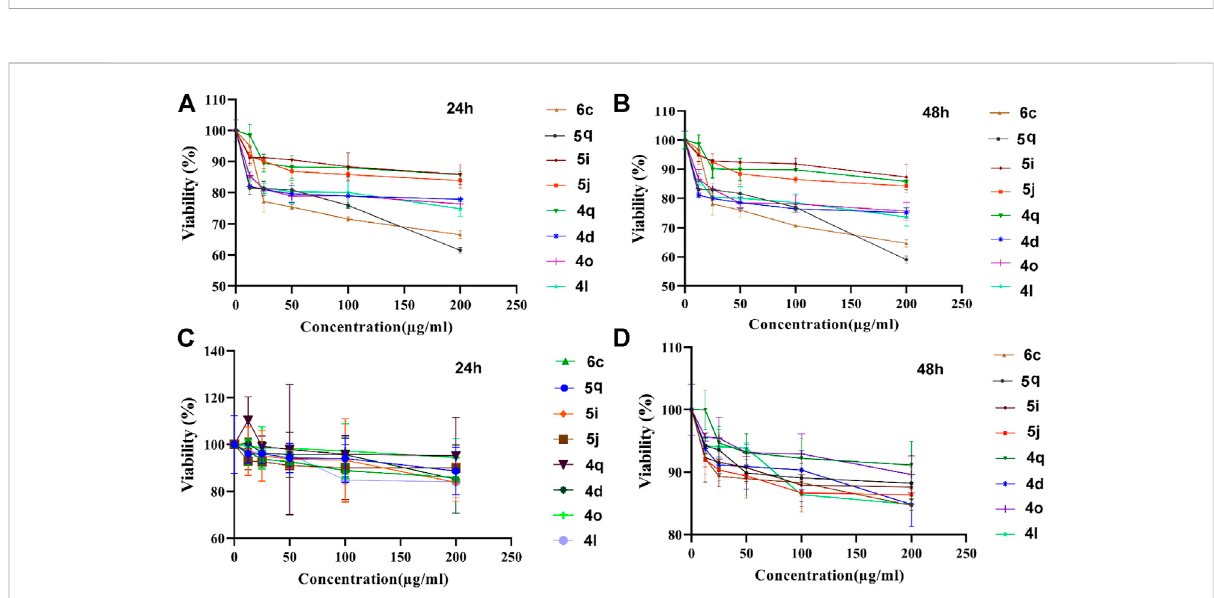
Anticancer activity of 1,4-dihydropyrano[2,3- c ]pyrazoles (4q, 4d, 4o, 4l), 4,4 ′ -(arylmethylene)bis(1H-pyrazole-5-ol) (5i, 5j, 5q), bis 4,4 ’ - (arylmethylene)bis(3-methyl-1H-pyrazol-5-ols) (6c) derivatives against HCT116 (A,B) and L929 (C,D) cell